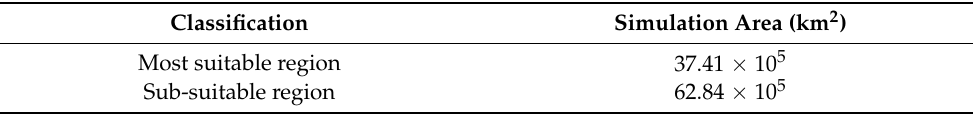
Table 3. Potential distribution area of Carex alatauensis